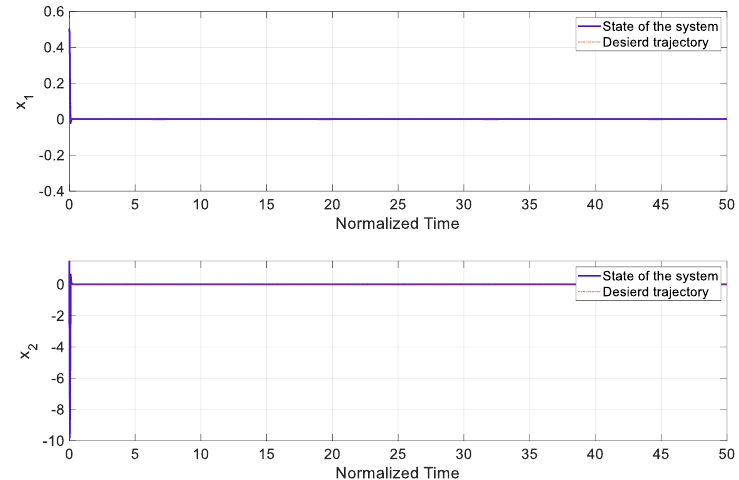
Figure 6. The states of the CNT with uncertain parameters and unknown disturbances using the suggested control technique method.